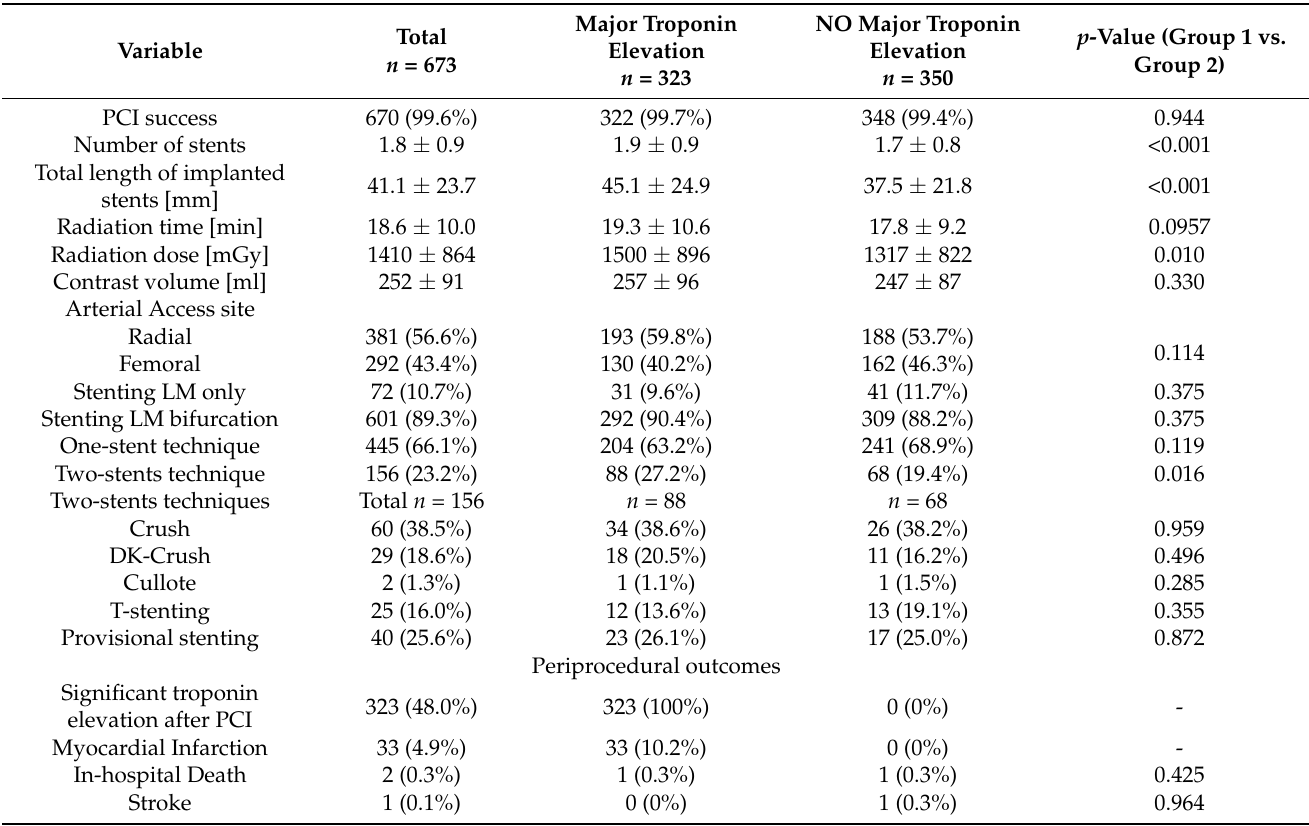
Table 4. Procedural